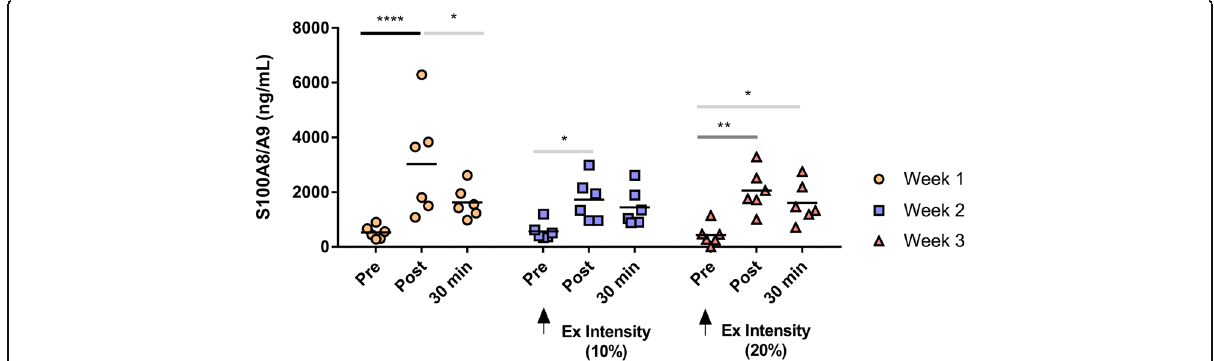
Fig. 4 Plasma [S100A8/A9] from individual participants during 3 weeks of exercise training. A main effect of time was observed ( P < 0.0001). Post